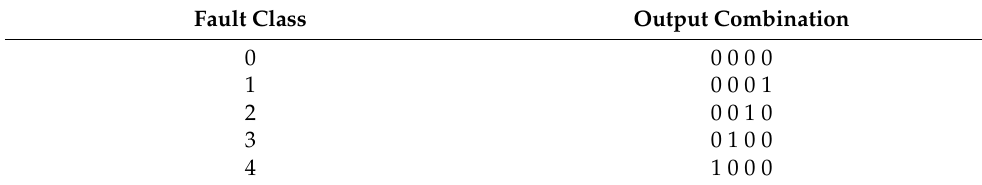
Table 5. Desired outputs of the